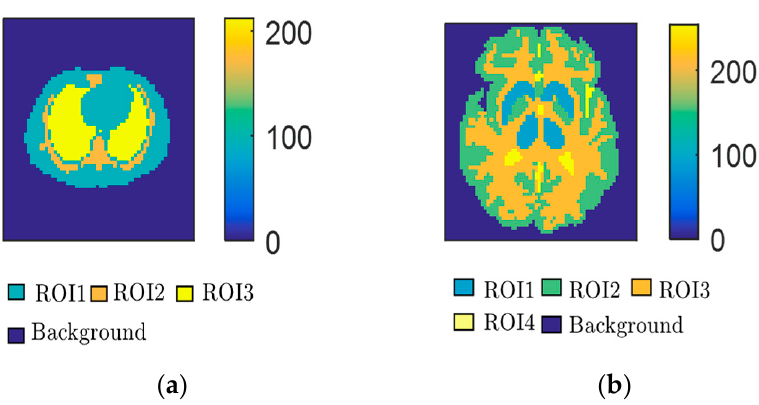
Figure 4. Two PET phantoms: ( a ) Zubal thorax phantom; ( b ) Zubal head phantom. Table 1. Dataset for simulation